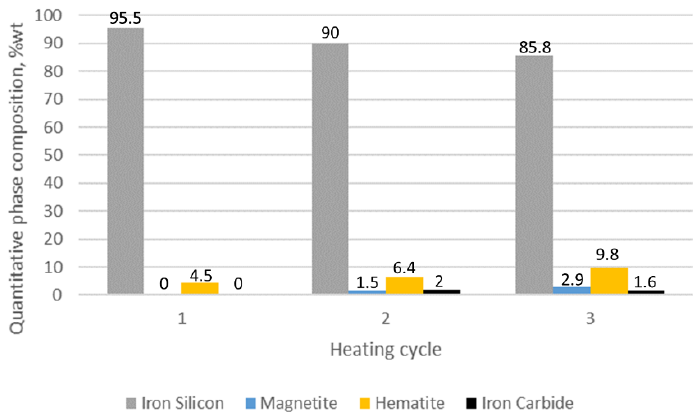
Figure 16. The quantitative share of outer oxide layer phase components for sample 3 as a function of heating cycles. of heating